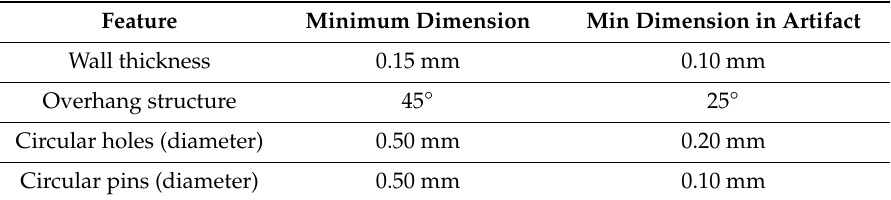
Table 3. Minimum dimension of features presented in benchmarking artifact.